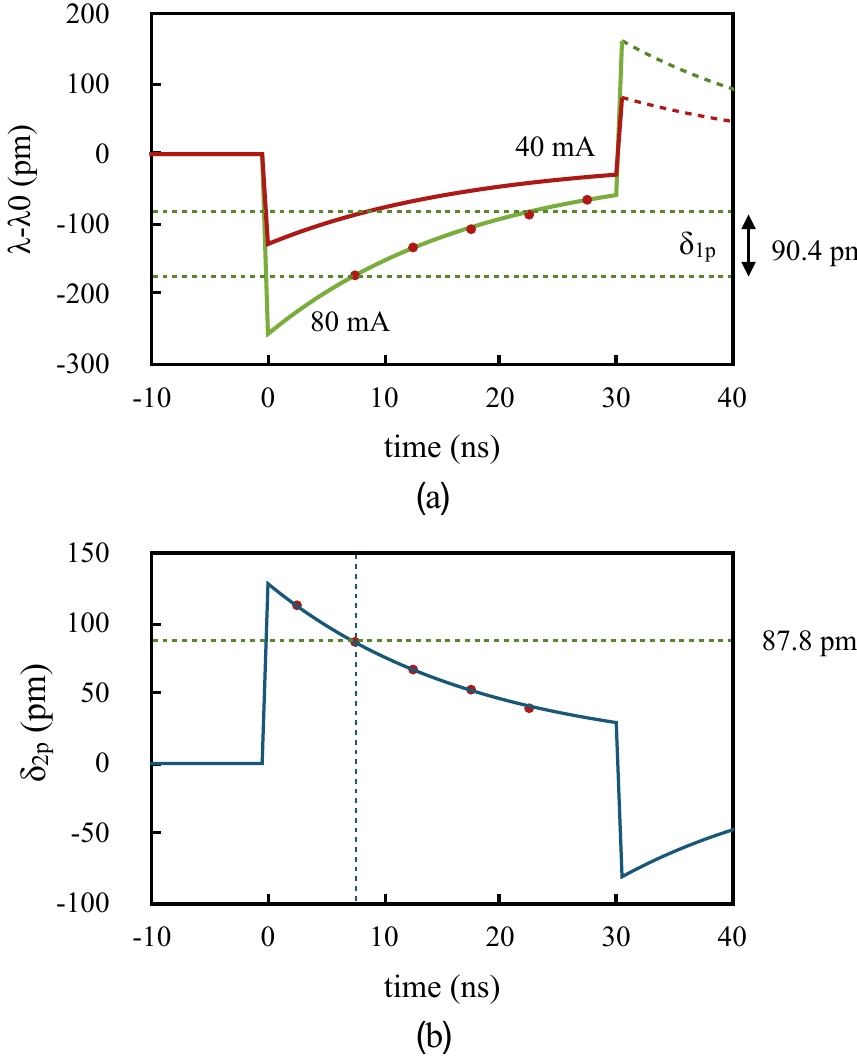
Figure 5. ( a ) Wavelength vs. time for 80 mA and 40 mA, 30 ns pulses; ( b ) Difference δ 2 p between the wavelengths of the 80 mA and 40 mA pulses. The dots are experimental measurements. The dotted lines in ( a ) represent the expected value of δ 1 p at 7.5 ns, and in ( b ) that of δ 2 p for 15 ns delay from the 7.5 ns